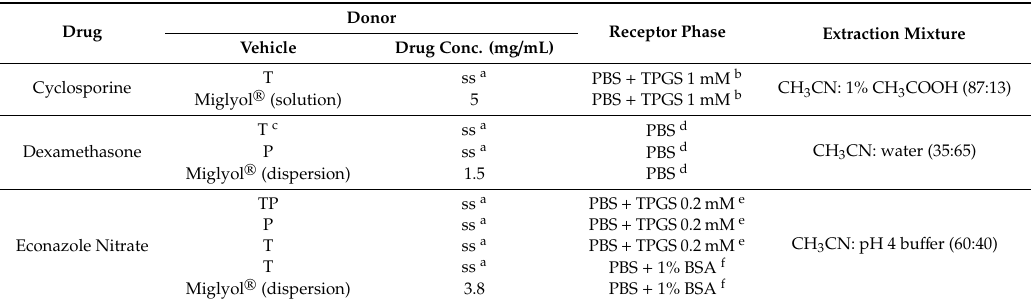
Table 2. List of the formulations selected for transconjunctival permeation experiments, composition of the receptor medium, and of the mixtures used for drug extraction from tissue.